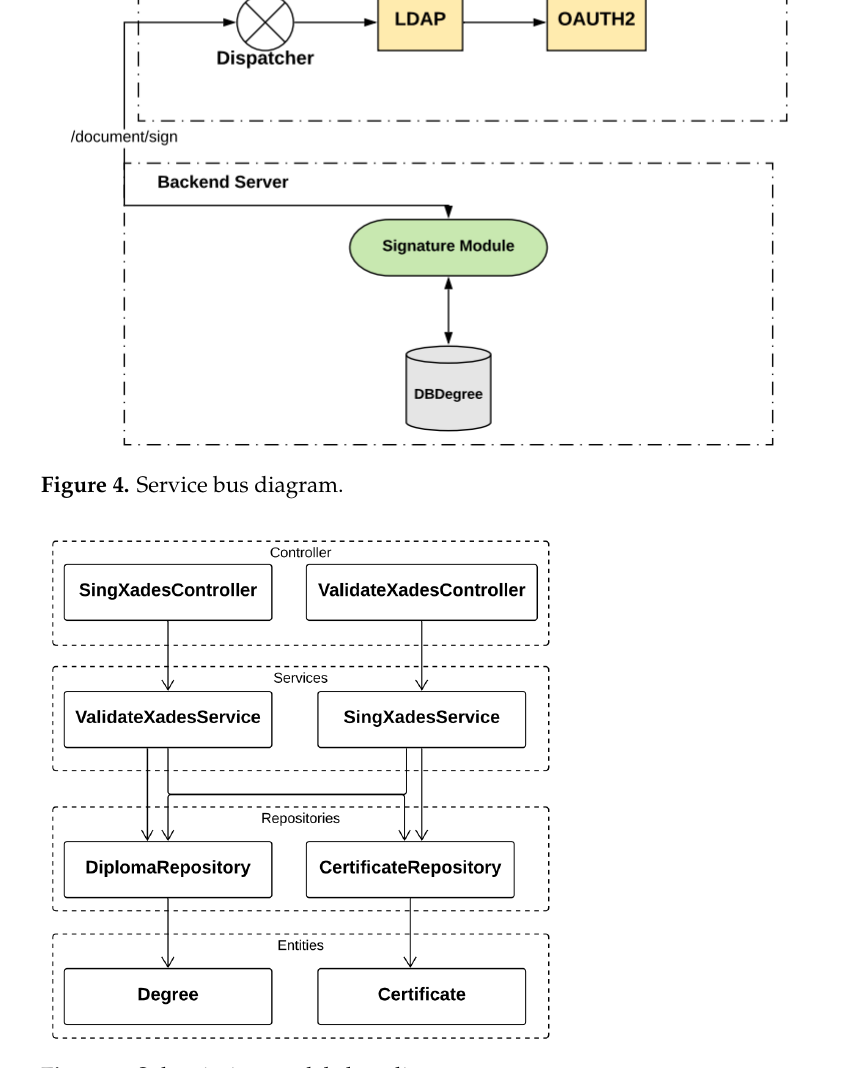
Figure 5. Subscription model class